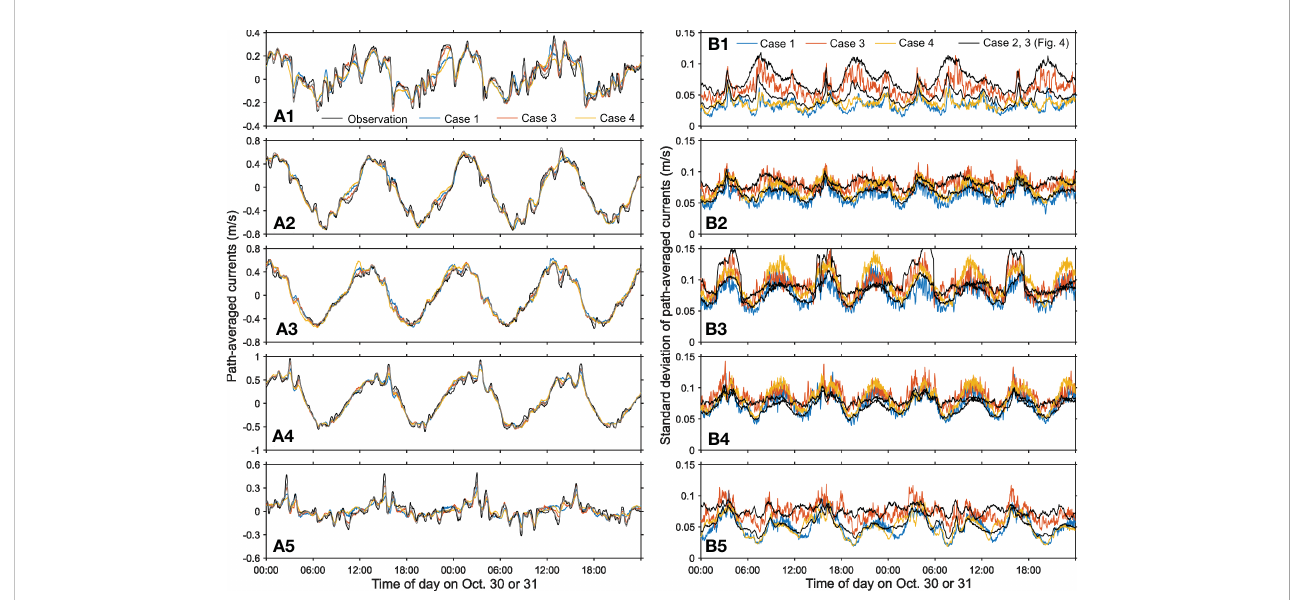
FIGURE 5 Same as Figure 3 but for the results of case 1 (blue), 3 (red), and 4 (yellow) with 42 ensemble members. The gray lines in panels (A1-A5) are the results of case 3 with 980 ensemble members. In panels (B1-B5) , the two black lines are the results of case 2 and 3 with 980 ensemble